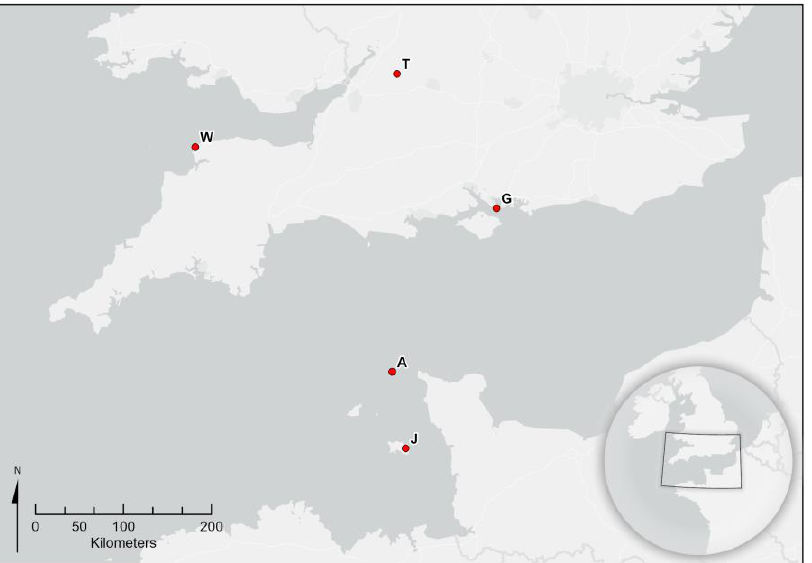
Figure 1. Map of Southern England and the Channel Islands showing the location of each nest used in the study. T: Tetbury, Gloucestershire, W: Woolacombe, Devon, G: Gosport, Hampshire, A: Alderney and J: Jersey. Table 1. List of the nests used with the approximate nest location (to preserve the anonymity of landowners), month the nest was captured and destroyed, the number of samples that were suc- cessfully sequenced (N. Seq), the average number of reads per larvae, the number of different spe- cies DNA found among the samples analysed, and the most abundant taxon found as a percentage of total reads per nest and the percentage of total reads per nest represented by Apis mellfera (honey bee).